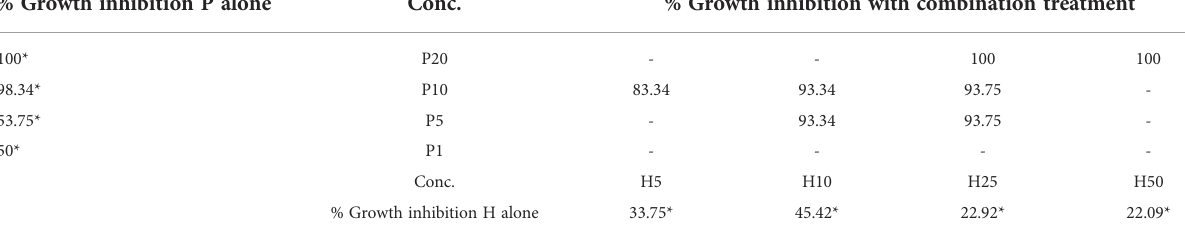
TABLE 3 Contingency table showing % growth inhibition of ZR75 colonies when treated with various drug concentrations and combinations. % Growth inhibition P